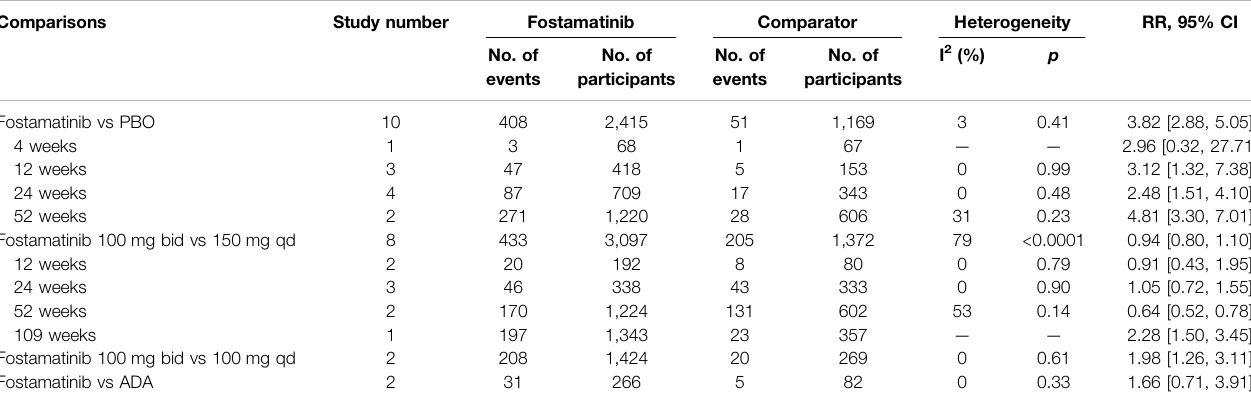
TABLE 3 | Pooled data of hypertension in RA